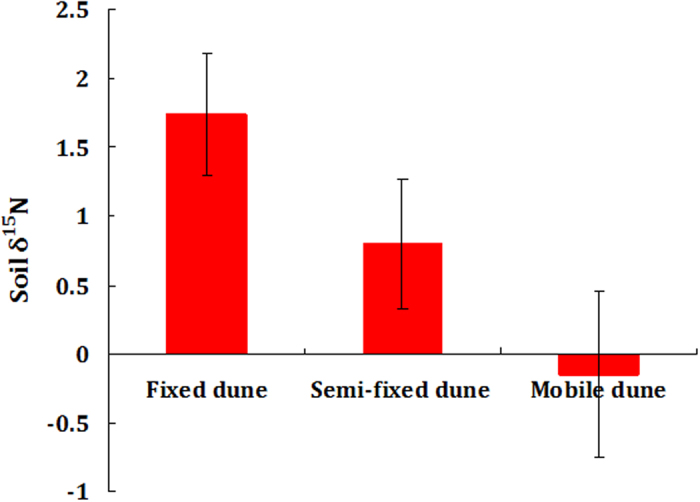
Soil δ15N values among the three types of dunes.